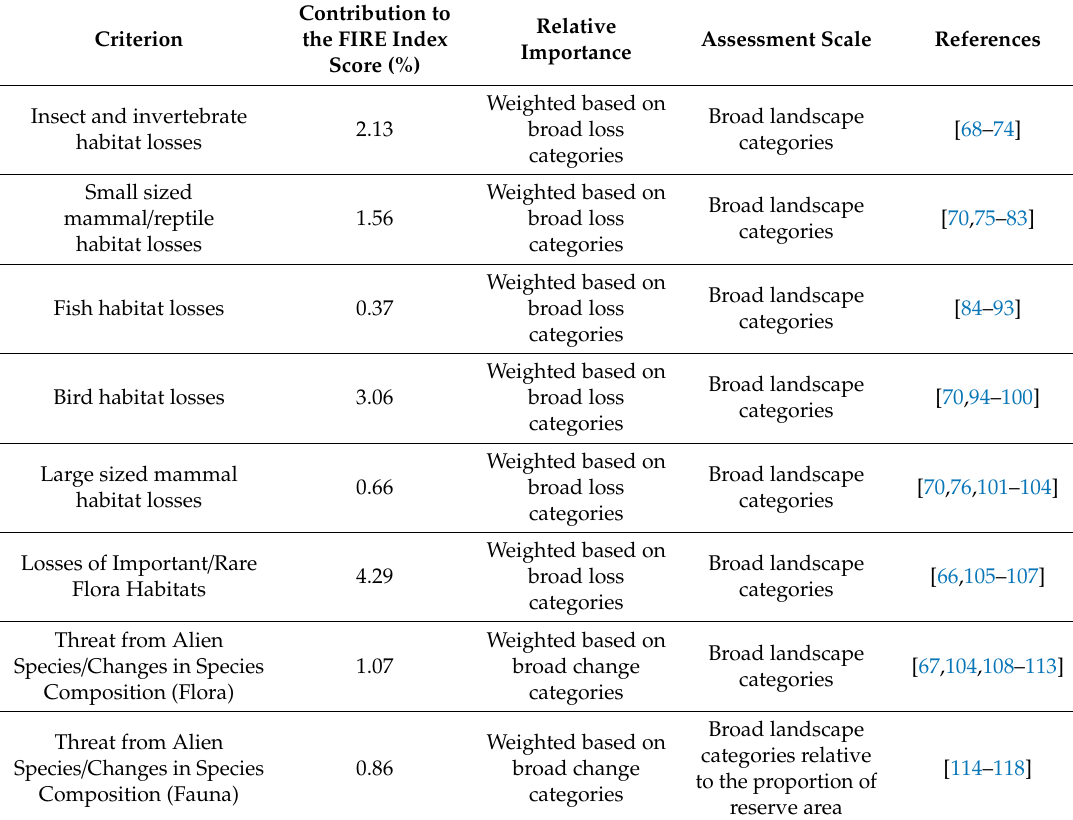
Table 2. Relative importance, assessment scale and relevant literature for each criterion for the general environmental impacts fire e ff ects